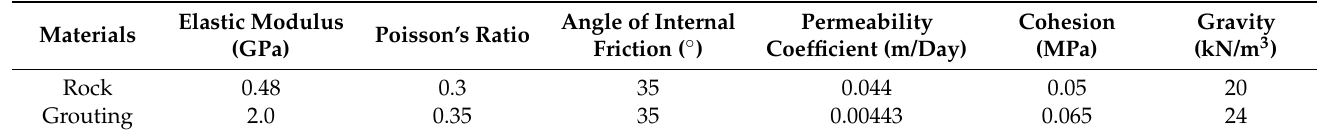
Figure 1. Diagram of the numerical calculation model for the damage of the grouted body. Table 1. Calculation parameters of the RFPA model.